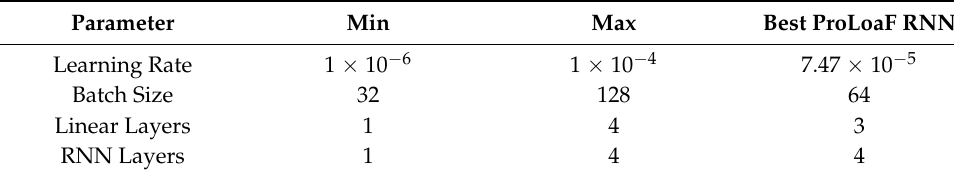
Table 4. Hyper parameter search space for net load forecast with